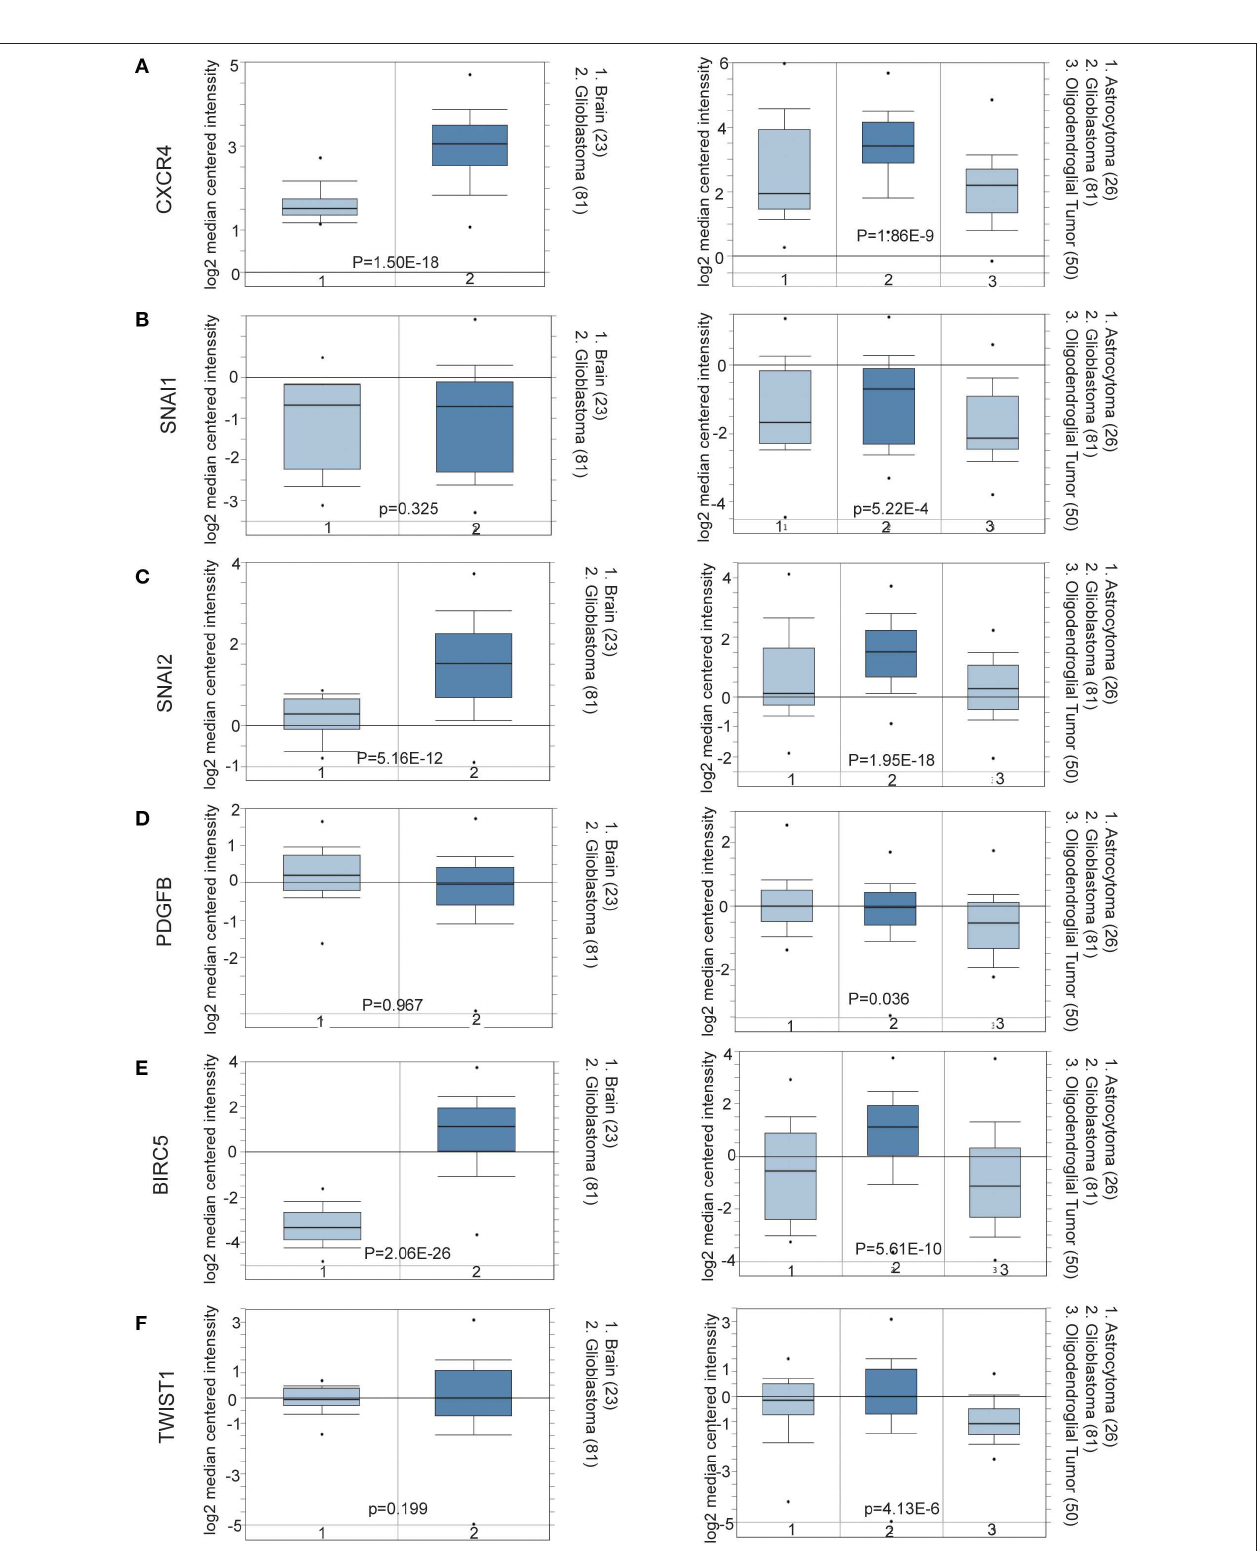
FIGURE 2 | (A–F) Oncomine data mining analysis of SNAI1, SNAI2, BIRC5, CXCR4, TWIST1, and PDGFB mRNA levels in Sun Brain dataset between normal brain tissues and different pathological grade brain glioma tissues.